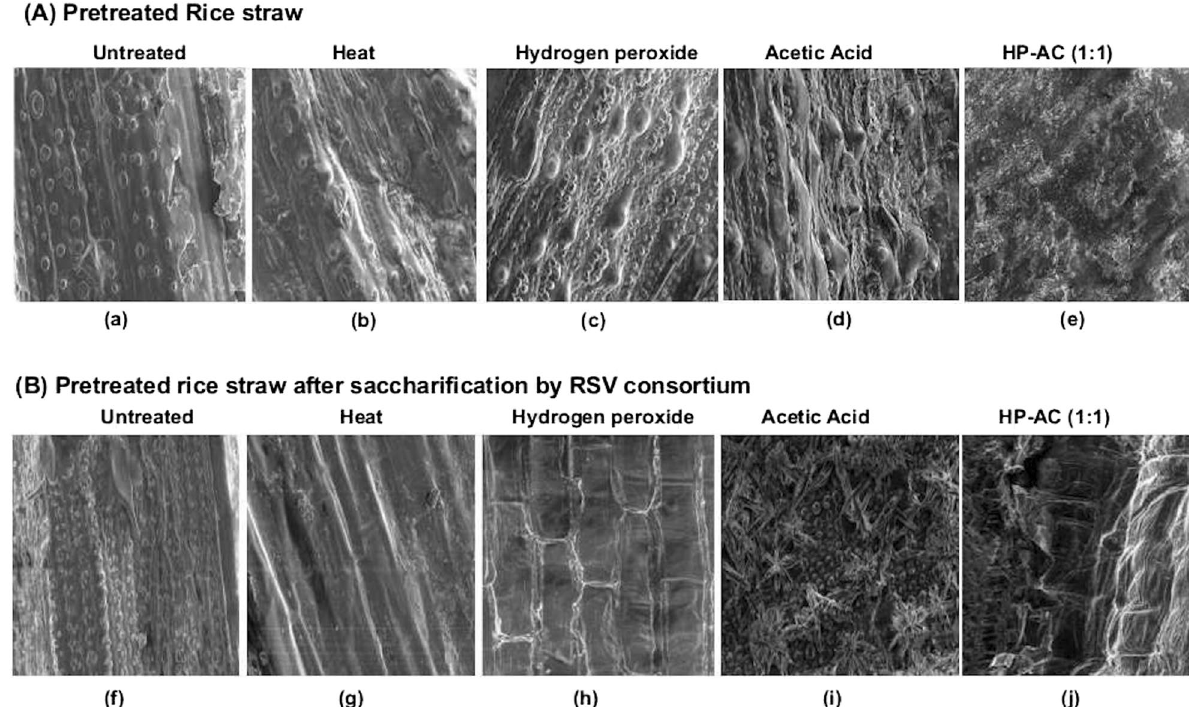
Figure 3. Scanning electron micrographs of pretreated rice straw before (Panel A , a–e) and after saccharification with RSV secretome (Panel B ,